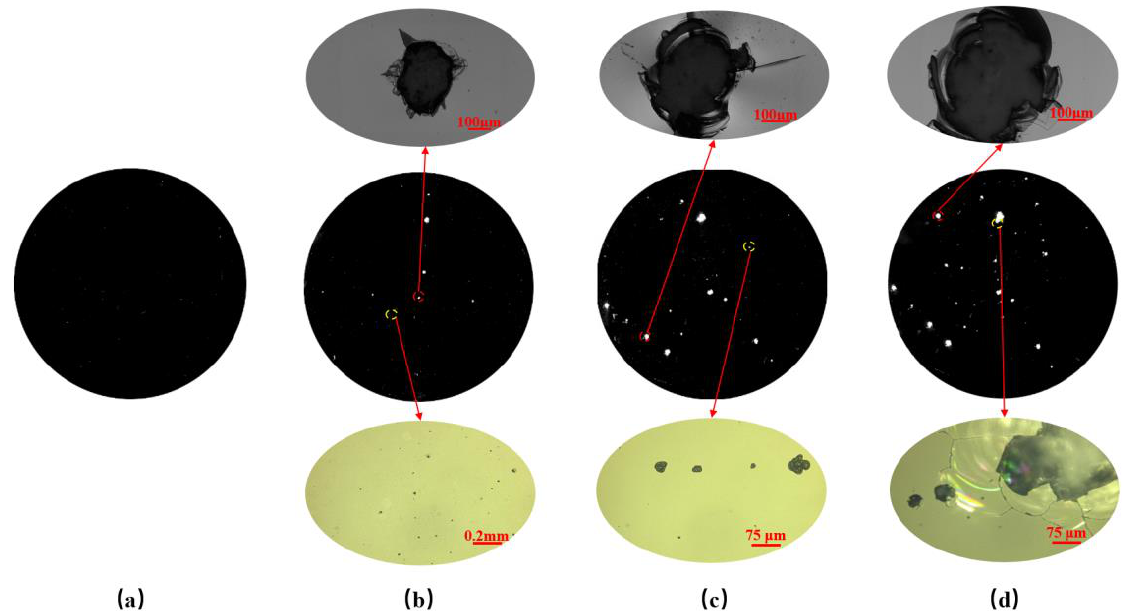
Figure 5. Laser scanning results: ( a ) Initial surface; ( b ) The result of first laser irradiation; ( c ) The result of second laser irradiation; ( d ) The result of third laser irradiation. Table 2. Statistics of defects with different